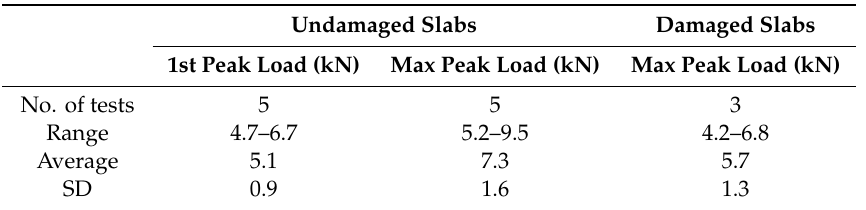
Table 5. Peak-load average value and standard deviation.